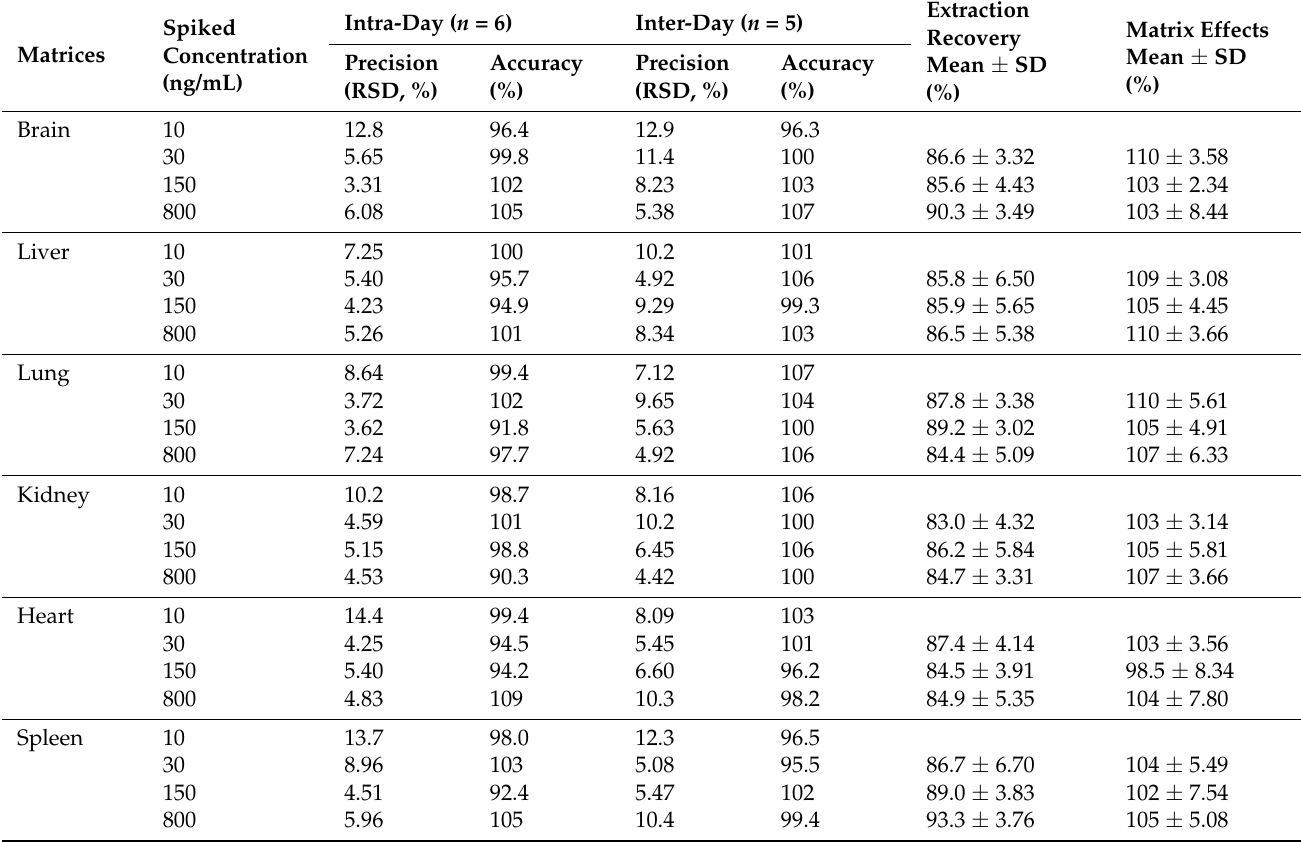
Table 2. Intra- and inter-day accuracy, precision, extraction recovery, and matrix effects of BIT in rat tissue